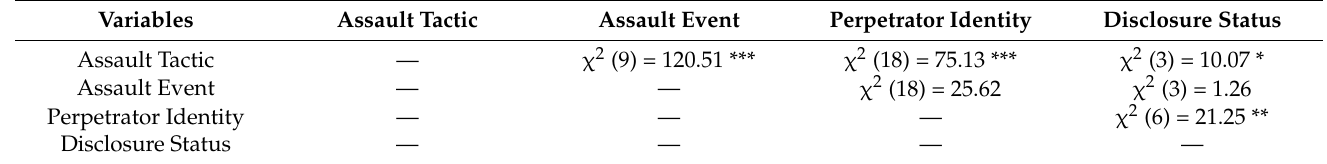
Table 1. Preliminary chi-square analyses among criterion